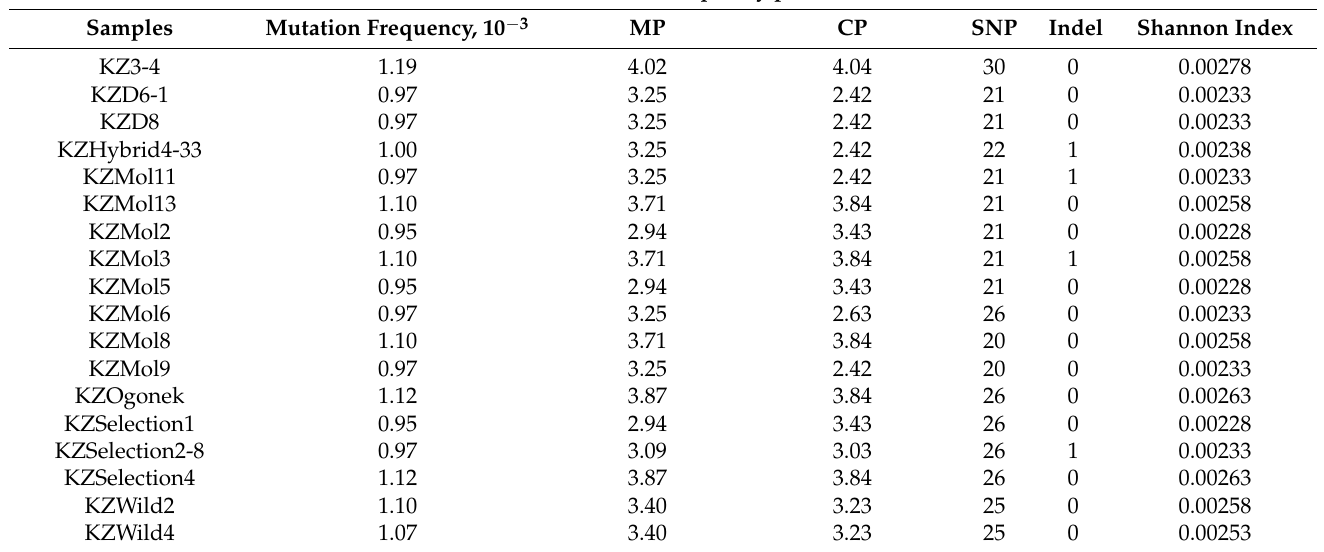
Table 3. Molecular characterization of mutant spectra for RNA2 of RBDV isolates: mutation frequency per genome and per gene. Numbers of SNPs, indels, nucleotide diversity, and Shannon index were estimated by retracting the 10 − 3 error rate correction.